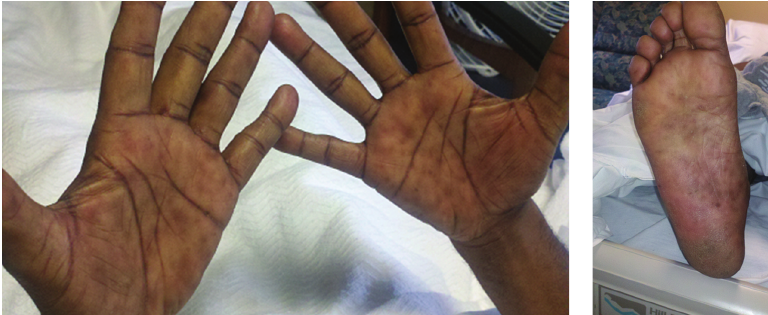
Figure3:Macularrashonbilateralpalmsandrightplantarsurface.Usedwithpermission:DepartmentofInternalMedicine,MedStarHarbor